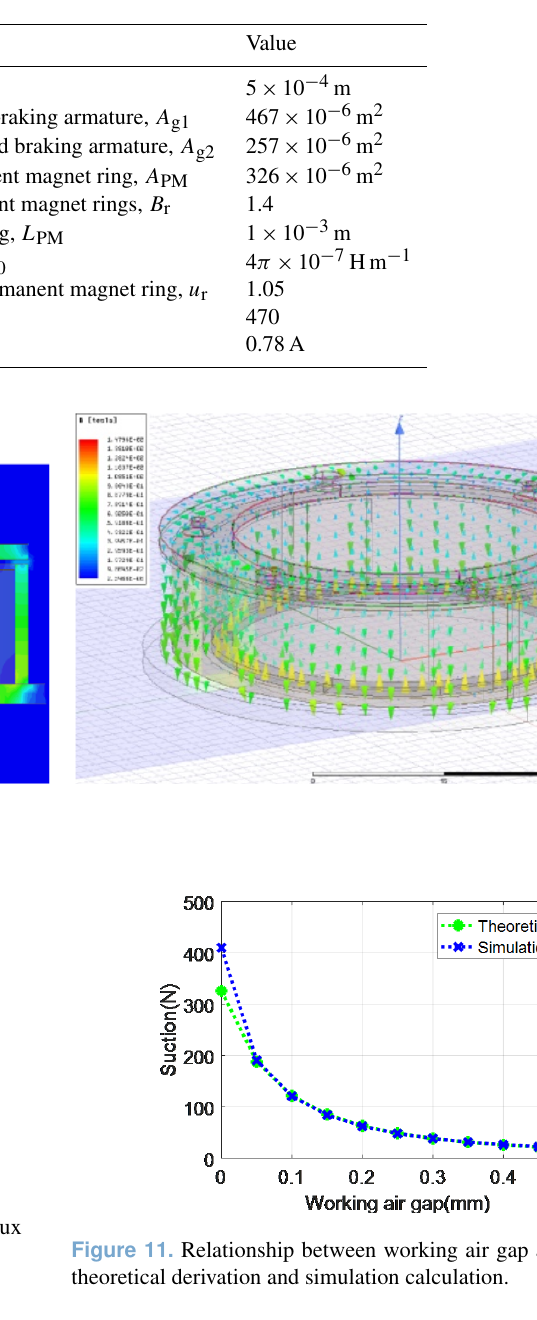
22 . 22 N mm − 1 , which is 3.1 % different from the theoreti- cal stiffness K Theo = 21 . 52 N mm − 1 . The theoretical model